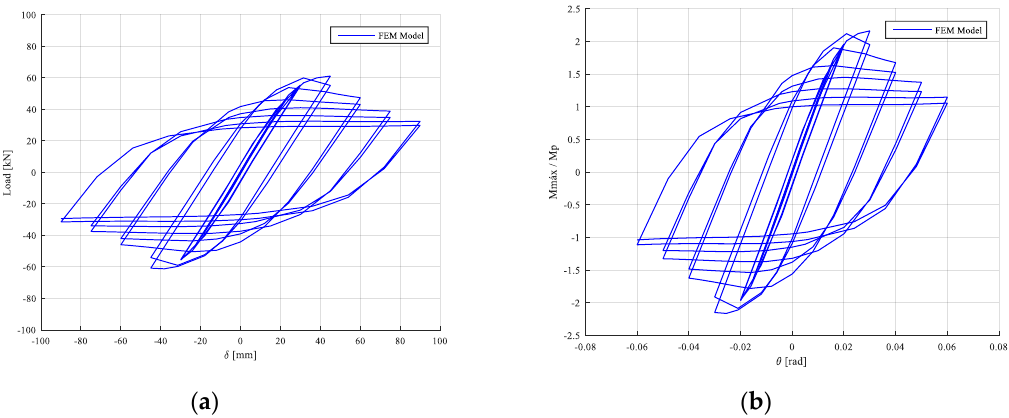
Figure 14. ( a ) Load vs. displacement curve, ( b ) normalized moment vs. rotation curve in numerical model.